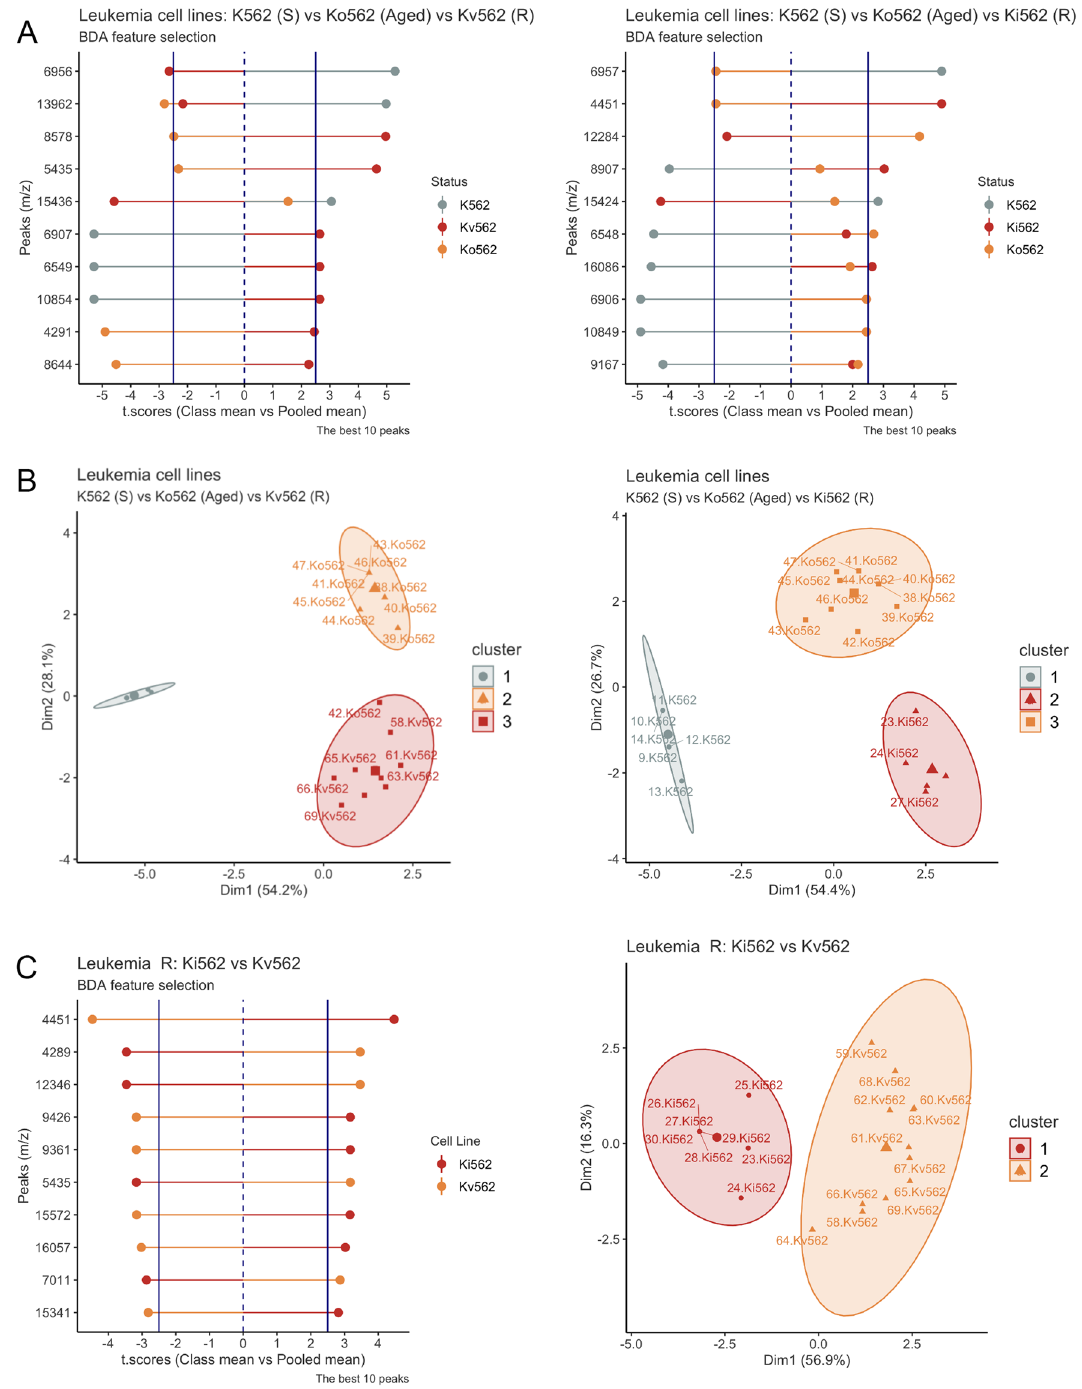
Figure 3. MALDI-TOF-MS analysis for the CML model. ( A ) Comparison between K562 (sensitive)/Ko562 (Aged-sensitive)/Kv562 (resistant) (left panel) and K562/Ko562/Ki562 (resistant) (right panel) for the selection of discriminant peaks by the BDA algorithm. The algorithm outputs the t.score (group means vs. pooled mean), which is graphed in the x-axes of both graphs, and the peaks (m/z) are plotted on the y-axis. The sign of the t.score indicates the presence (positive) or the absence (negative) of that peak in that group. The groups are indicated with different colors. The differences have a 95% significance when the value of the t.score is equal to or greater than 2.5 (increased) and equal to or less than − 2.5 (diminished). ( B ) Spectra pattern comparison between K562/Ko562/Kv562 (left panel) and K562/Ko562/Ki562 (right panel), was performed by the Hierarchical k-means clustering with a Principal Component Analysis visualization (HKmC-PCA). Each point on the graph corresponds to each experimental replicate. The label indicates an ID number of the spectrum and the cell line name. The spectra patterns were grouped in 3 clusters represented by different geometric symbols and colors. Lastly, the ellipses of each cluster represent 95% of confidence from the centroid, considering a normal distribution multivariate. ( C ) Comparison between the resistant cells Kv562/ Ki562. Left panel: discriminant peaks by the BDA algorithm and right panel: